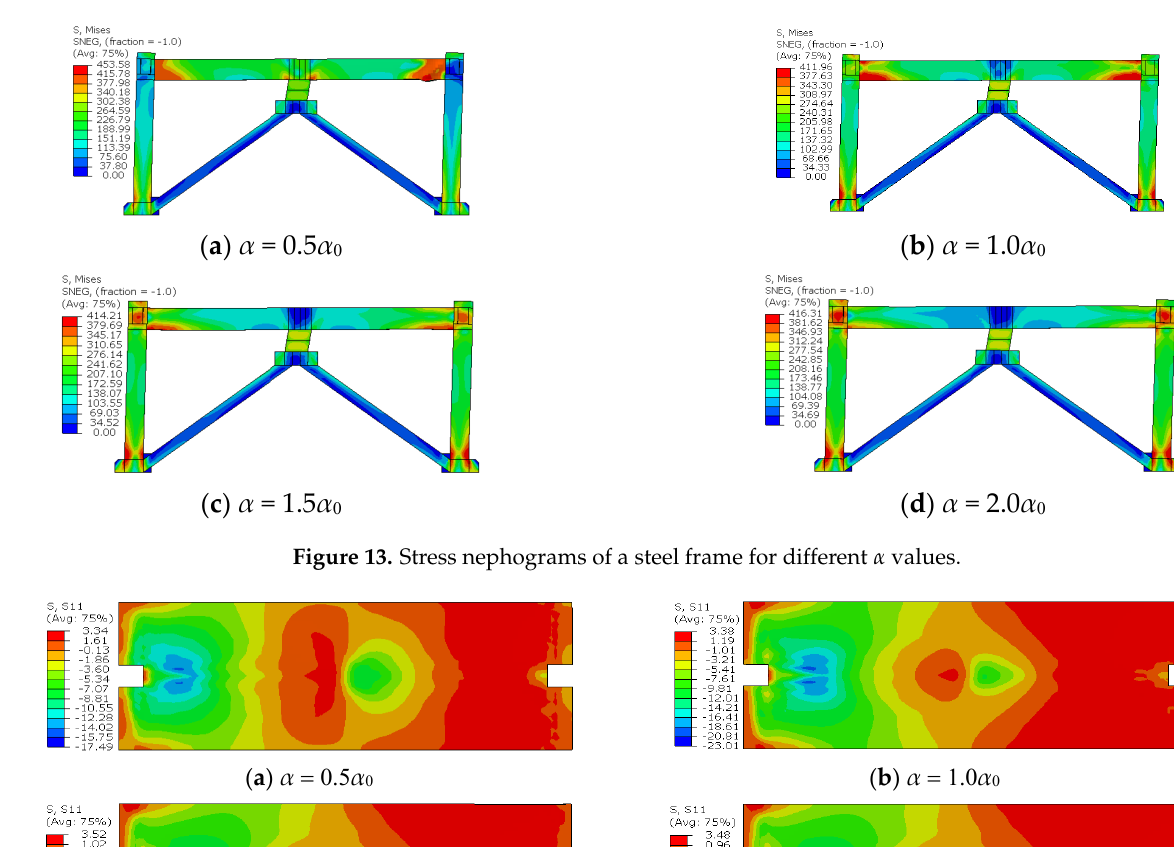
Figure 14. Stress nephograms of a concrete slab for different α values.